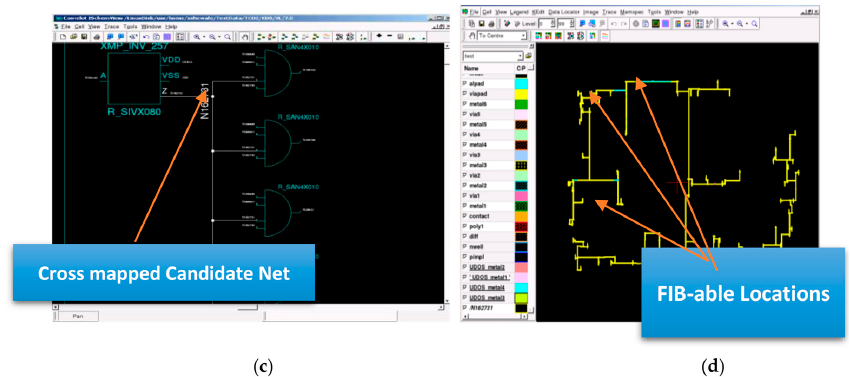
Figure 24. Use flow with FIB ( a ) Top cell view of IC layout ( b ) Zoomed in view of diagnostics net ( c ) Cross-mapped net to schematic view ( d ) Identifying the Fibable regions in layout.